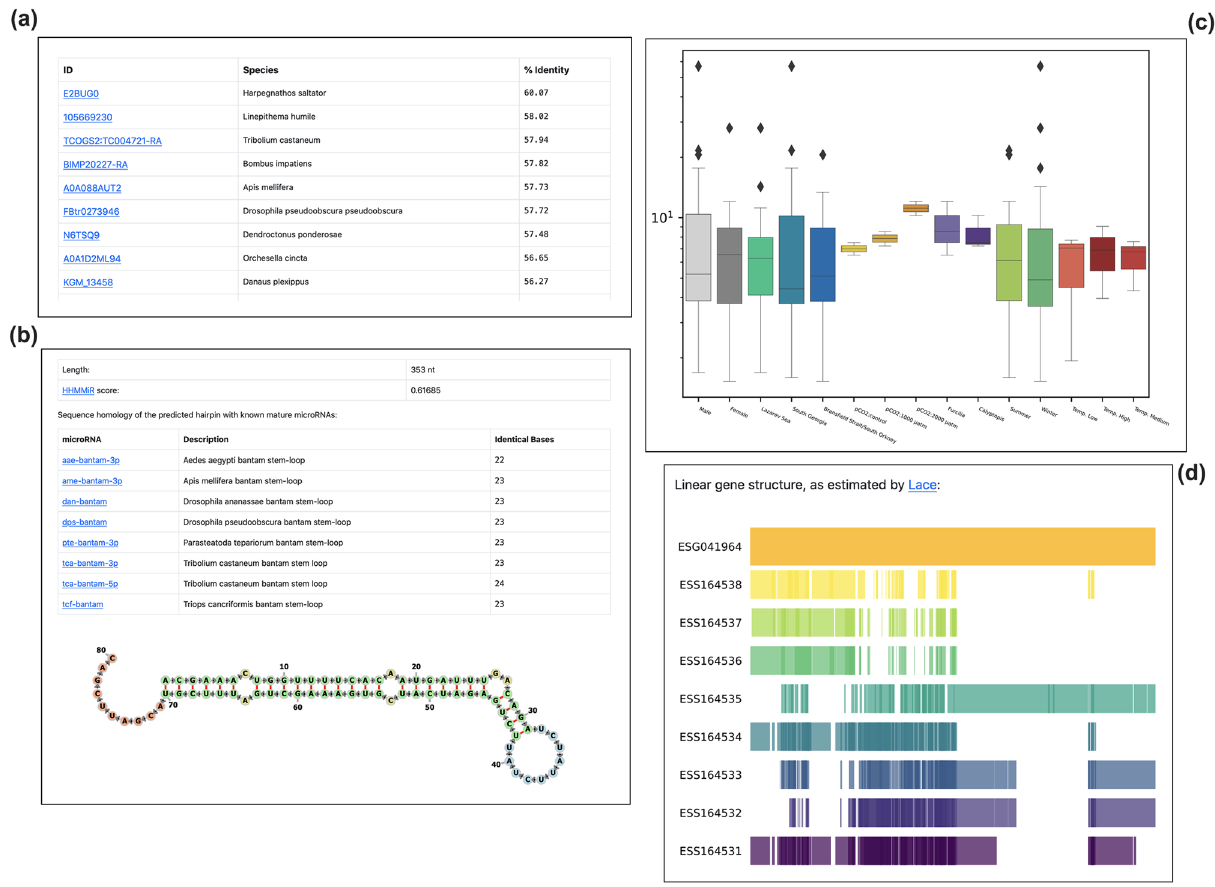
Figure 6. Additional sections in gene and transcript pages. The new sections in the gene-centric page show a table listing the orthologous sequences with their belonging species and the identity score ( a ), a visualization of the gene structure as estimated by Lace software ( d ) and a boxplot coming from Expression Atlas analyses ( c ). Both Orthology and Expression sections are integrated also in the transcript-centric page. When a transcript is annotated as a putative microRNA, a “Predicted Hairpin” section displays a visualization of the hairpin predicted secondary structure and tables showing the alignment length, the HHMMiR score and the list of mature microRNAs matching ( b